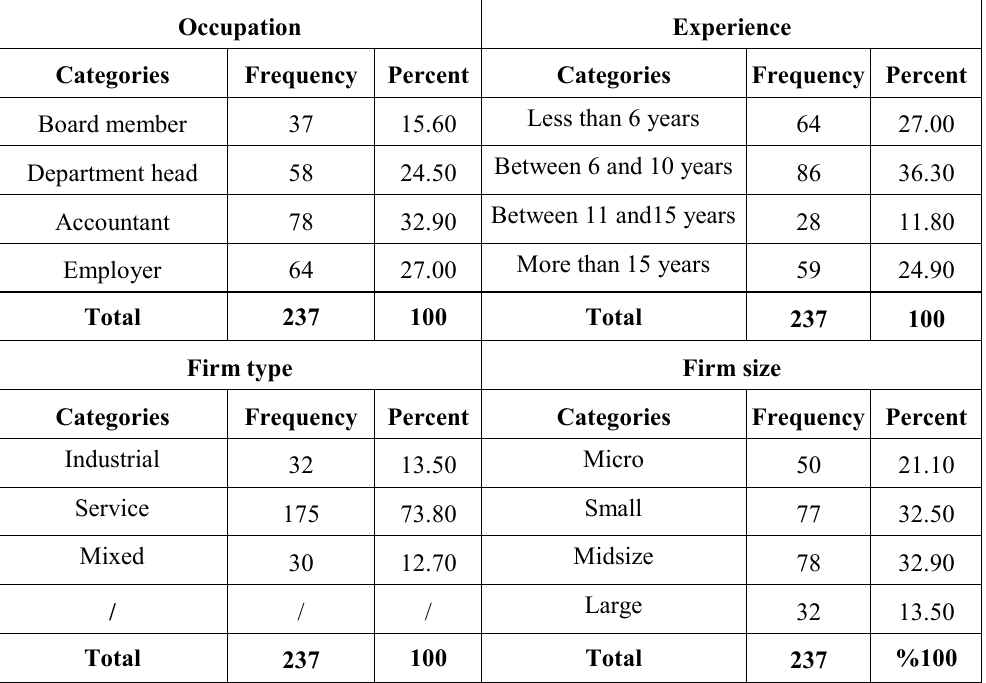
Table 4. Distribution of the Study